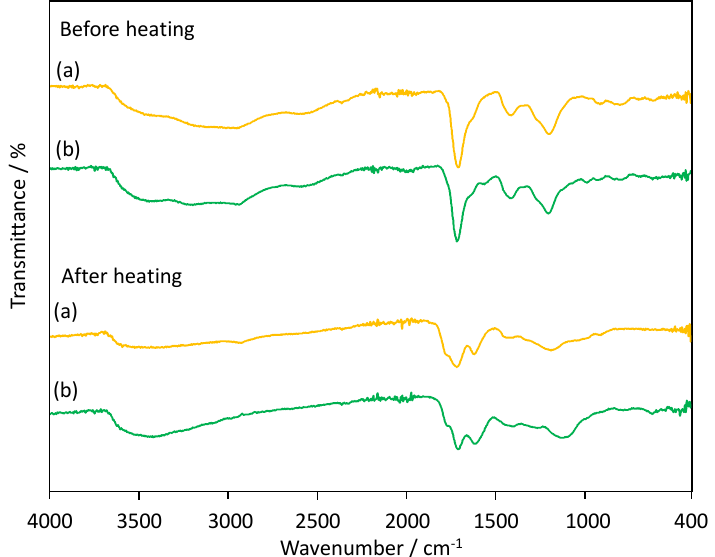
Figure 5. FT-IR spectra of (a) poly(IA) and (b) poly(IA- co -10-HHIA) synthesized with an IA/10-HHIA monomer ratio of 160/40 μmol (code 2) before and after heating at 200 °C for 18 h.